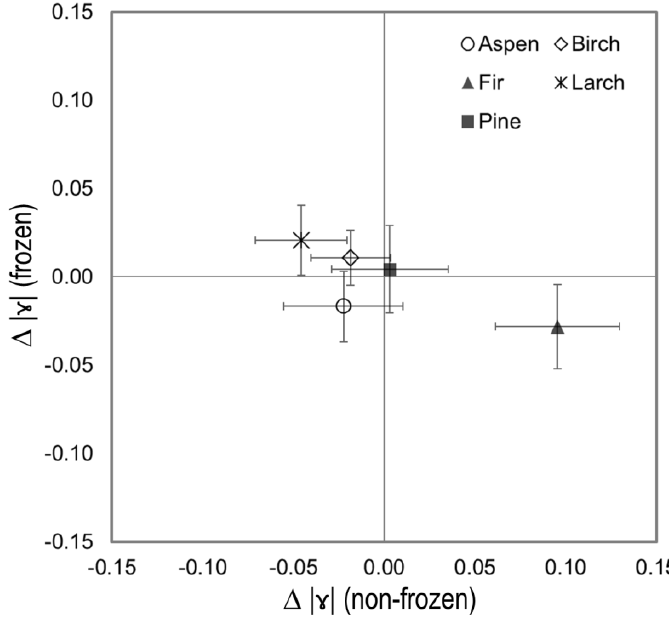
Figure 5. Deviation ∆ of tree species specific | γ | from average | γ | of dense forest for frozen and non-frozen conditions—all sites. The average | γ | of dense forest is shown in Figure